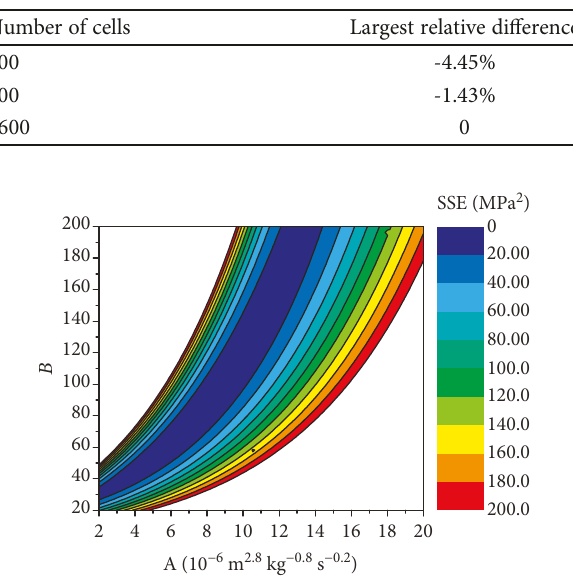
Figure 4: Contour of SSE. The values larger than 200 are neglected.